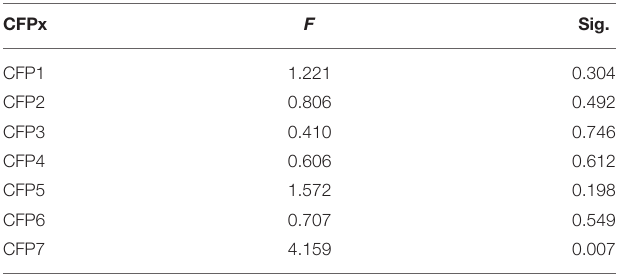
TABLE 4 | Levene’s test of equality of error variances: F -value and significances of the seven permutations of chaotic global parameters (CFP1 to CFP7). CFPx F Sig. CFP1